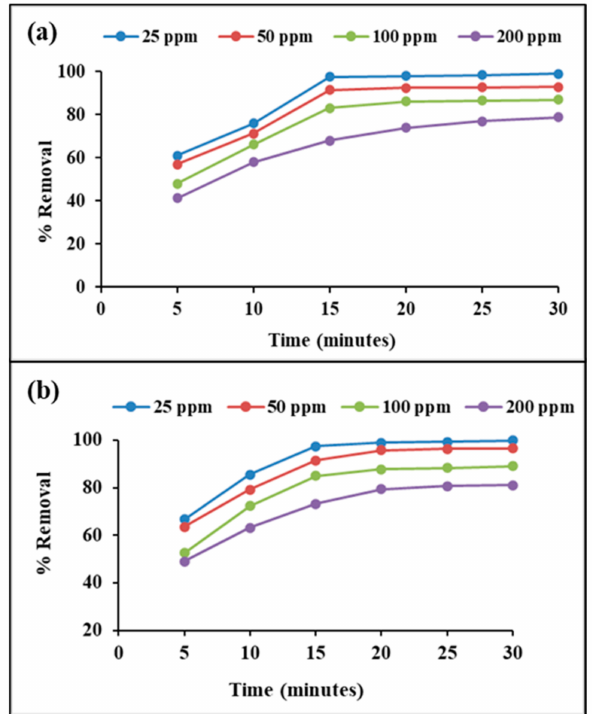
Figure 8. Removal percentage of MB using ( a ) MMT clay and ( b ) MMT/Ag